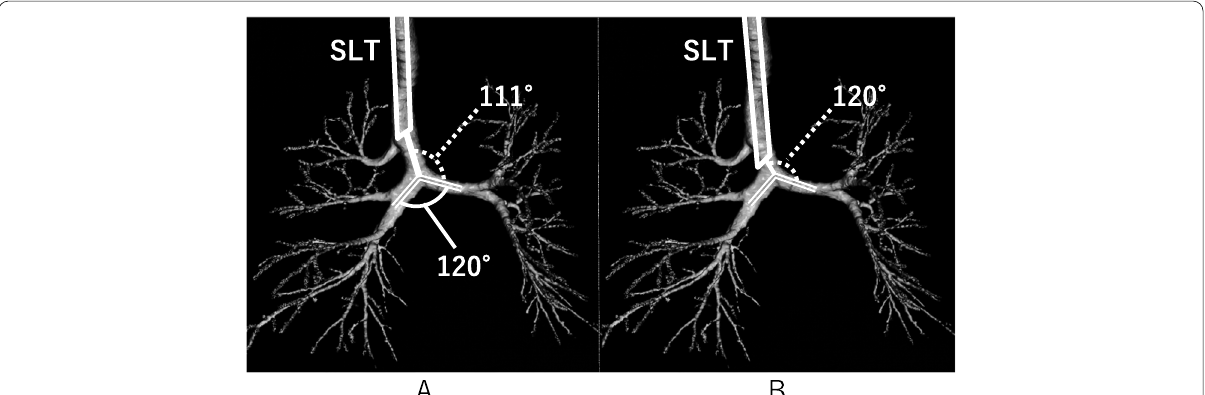
Fig. 2 Three-dimensional (3D) image evaluation of the airway. Entry angles from the SLT tip were 111° and 120° when the tip was placed above the TB entry ( A ) and tracheal bifurcation ( B ), respectively. Main bronchus angle was 120° ( A ). SLT: single-lumen endotracheal tube, TB: tracheal bronchus